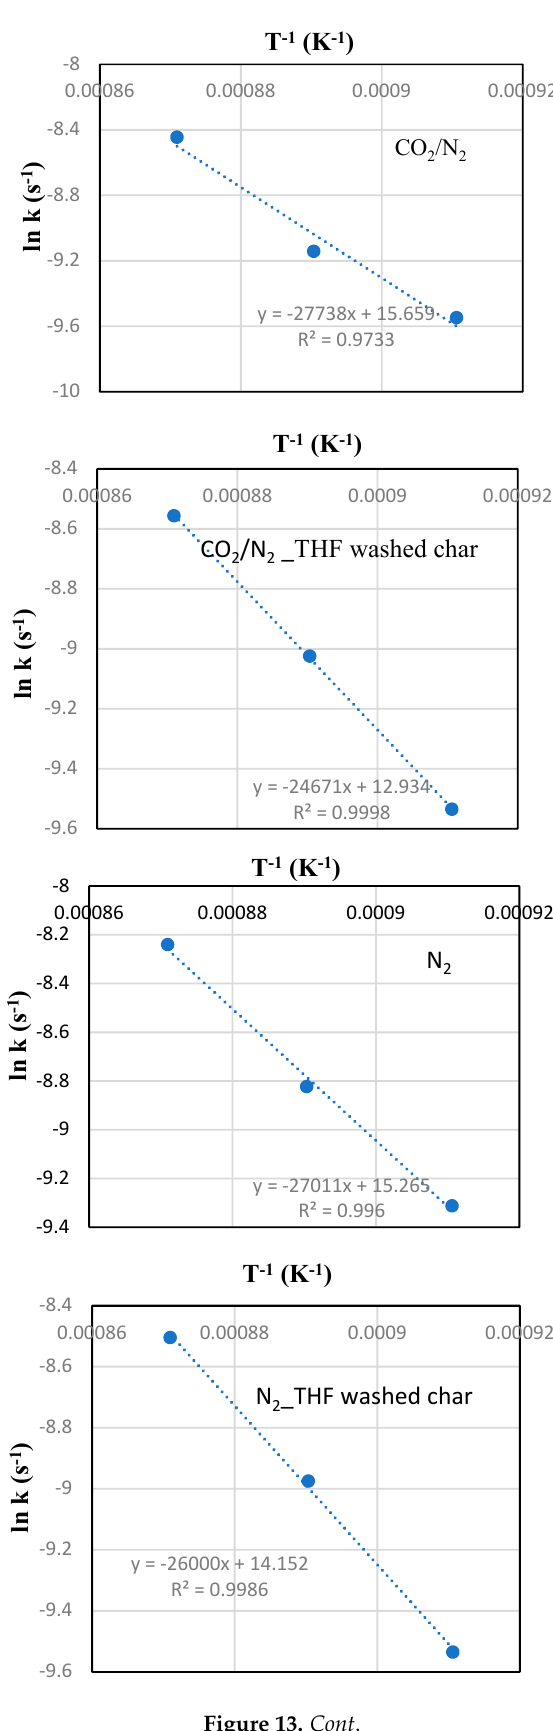
Figure 12 . Instantaneous reaction rates of chars with conversion (before and after washing with THF).